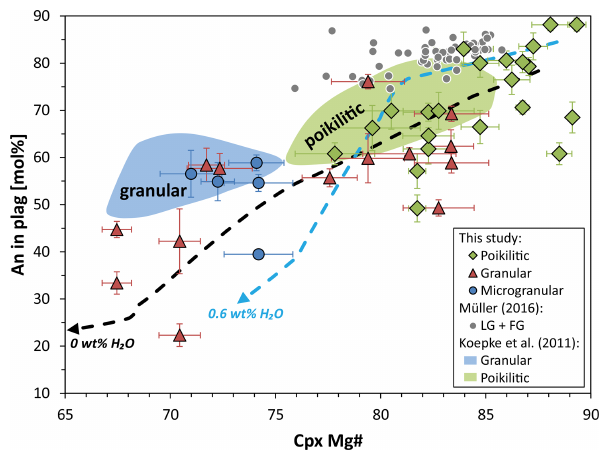
Figure 16. Sample averages of An content in plagioclase versus Mg# in clinopyroxene evolution trends for varitextured gabbros from the GT3A drill core, shown for the different textural domains (poikilitic, granular, microgranular). Green and blue fields define poikilitic and granular domains from varitextured gabbros from IODP hole 1256D (EPR, from Koepke et al., 2011). The data of the GT3A drill core show a similar correlation to those from the EPR but with generally higher An contents, which is due to the hydrous nature of the Oman parental melts. Data from typical lay- ered and foliated gabbro from the lower gabbroic crust of the Oman ophiolite (Wadi Gideah; Müller, 2016) are also included, spanning a compositional field which is significantly different compared to the varitextured gabbros from the dike–gabbro transition. The black and the blue arrows correspond to evolution trends modeled for frac- tional crystallization with MELTS for 0wt% and 0.6wt% initial H 2 O. From this, it is obvious that at least the start of differentiation recorded in the poikilitic domains proceeded at high water activities. Error bars are the 1 σ standard deviation for clinopyroxene Mg# and plagioclase An content.